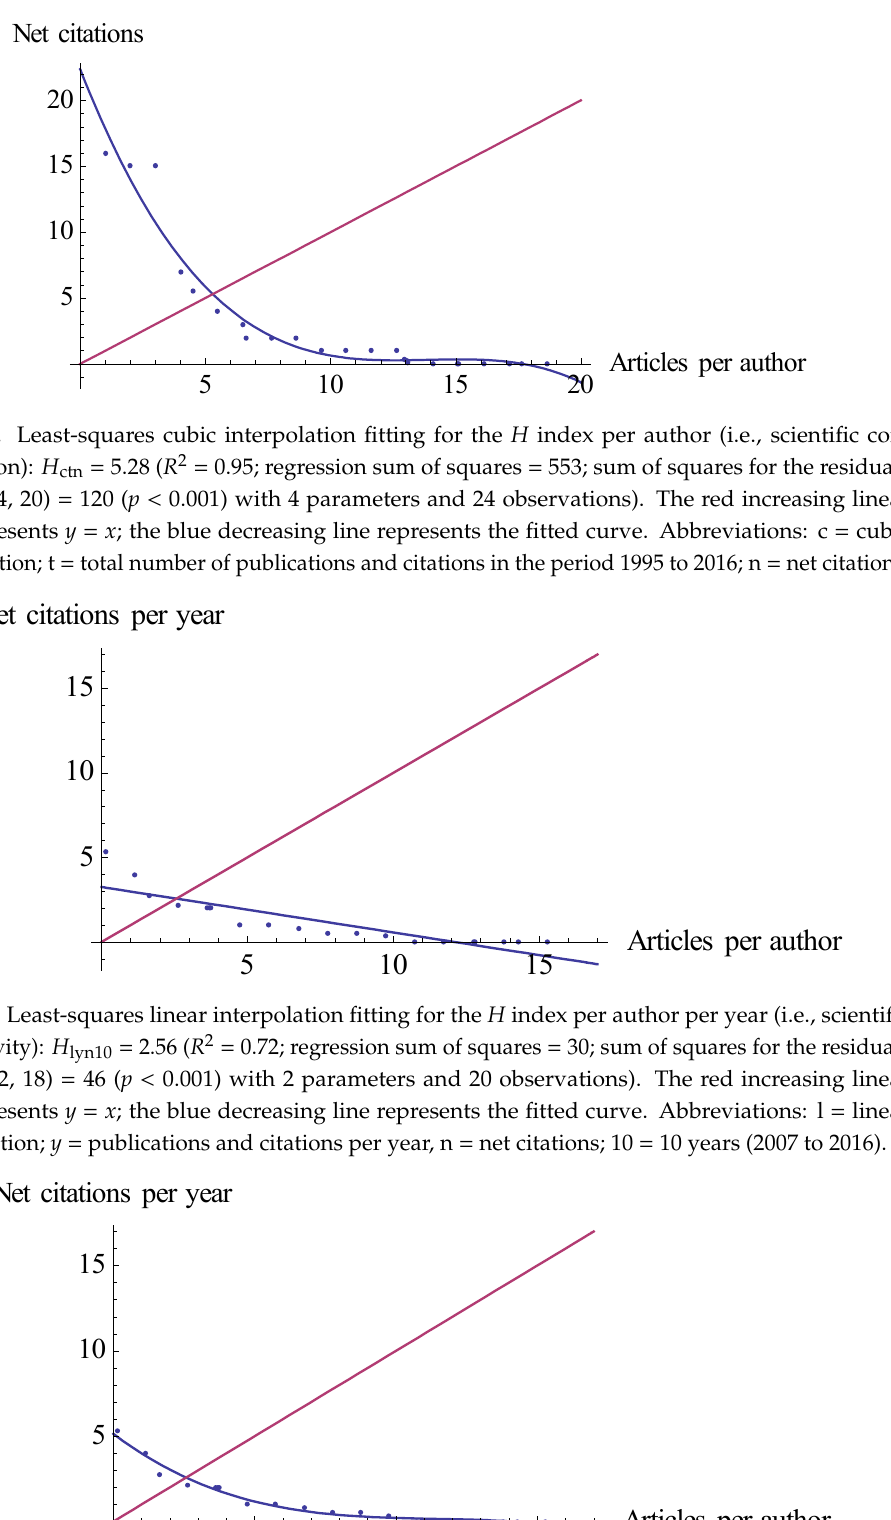
Figure 1. Least-squares linear interpolation fitting for the H index per author (i.e., scientific production): H ltn = 6.29 ( R 2 = 0.66; regression sum of squares = 389; sum of squares for the residuals = 195; F (2, 22) = 44 ( p < 0.001) with 2 parameters and 24 observations). The red increasing line represents y = x ; the blue decreasing line represents the fitted curve. Abbreviations: l = linear interpolation; t = total number of publications and citations in the period 1995 to 2016; n = net citations.